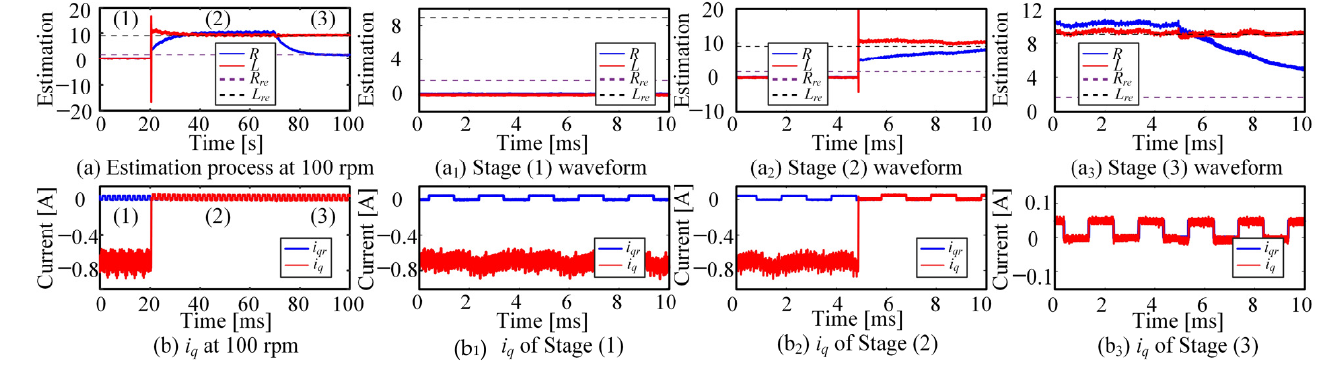
Figure 13. The parameter identification results at 100 rpm.